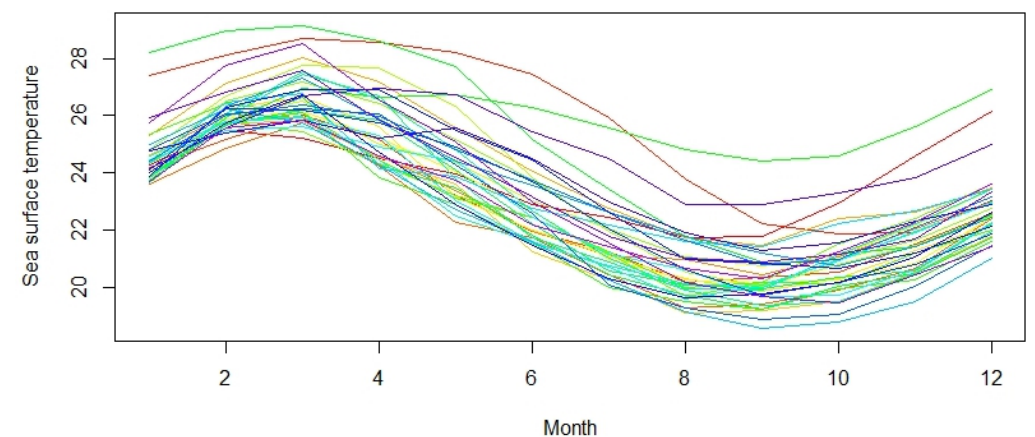
Figure 1. Monthly sea surface temperatures.